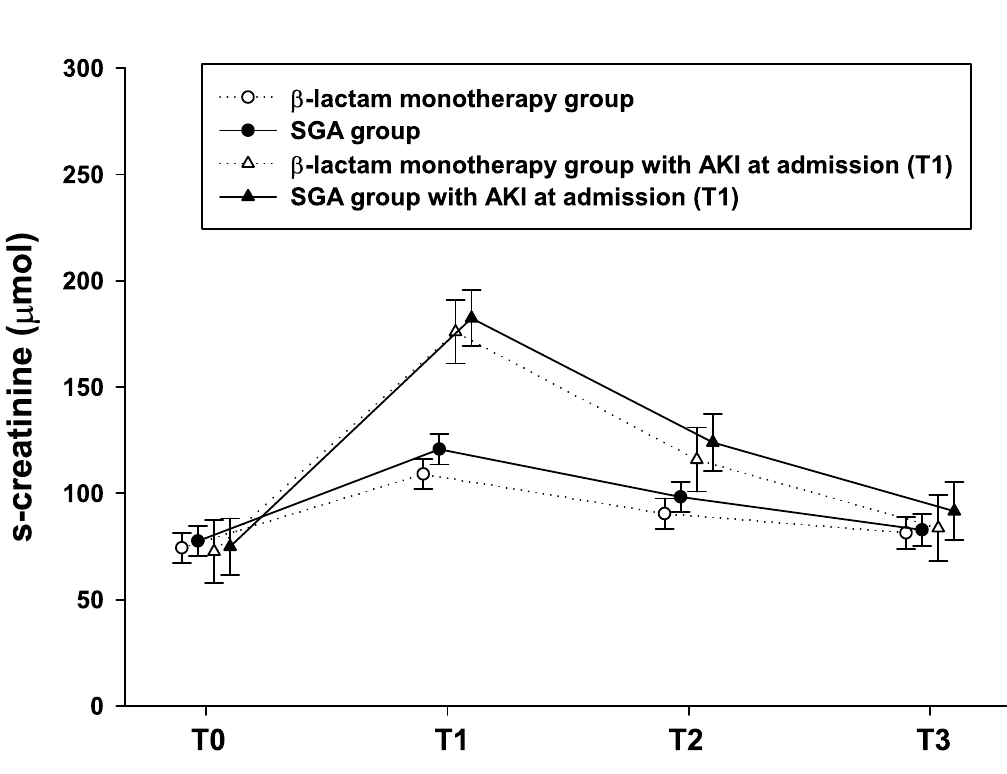
Fig 3. AKI. Mean creatinine from T0 to T3 in β -lactam monotherapy group and SGA group as well for each study group with only patients with AKI at admission (T1). Estimated mean creatinine with 95% confidence intervals by linear mixed model, see statistical section for